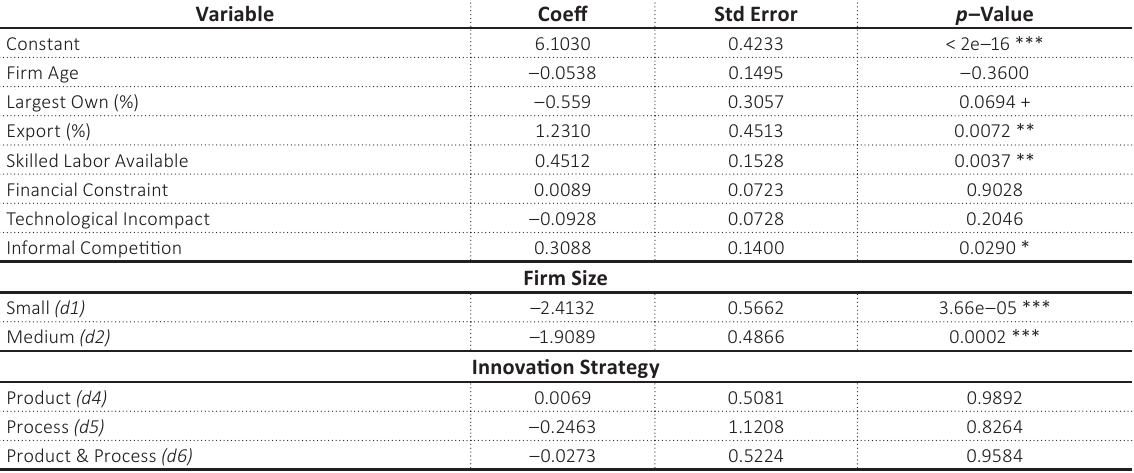
Table 5. OLS regression results of the determinants of R&D